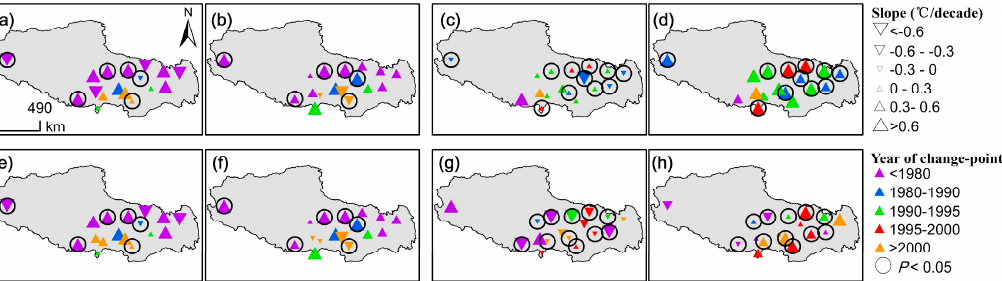
Figure 4. Same as Figure 3, but for the cold season.